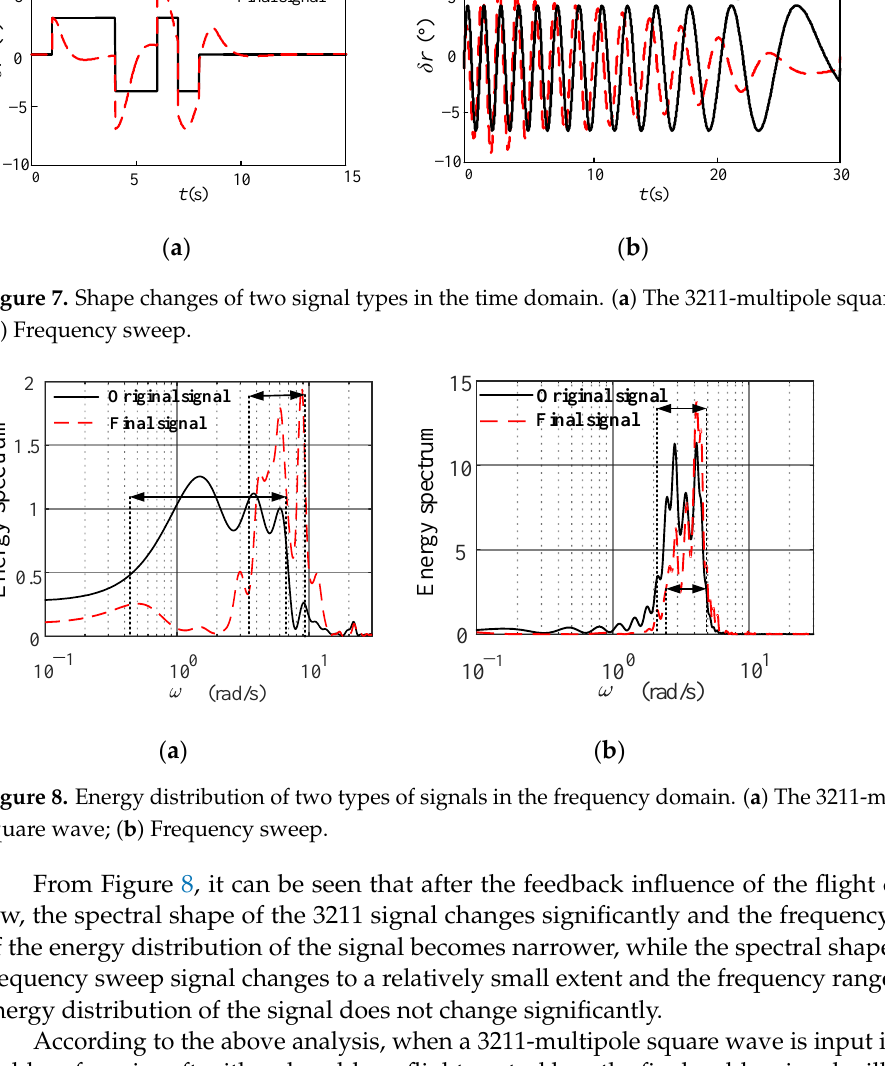
Figure 8. Energy distribution of two types of signals in the frequency domain. ( a ) The 3211-multi- pole square wave; ( b ) Frequency sweep.